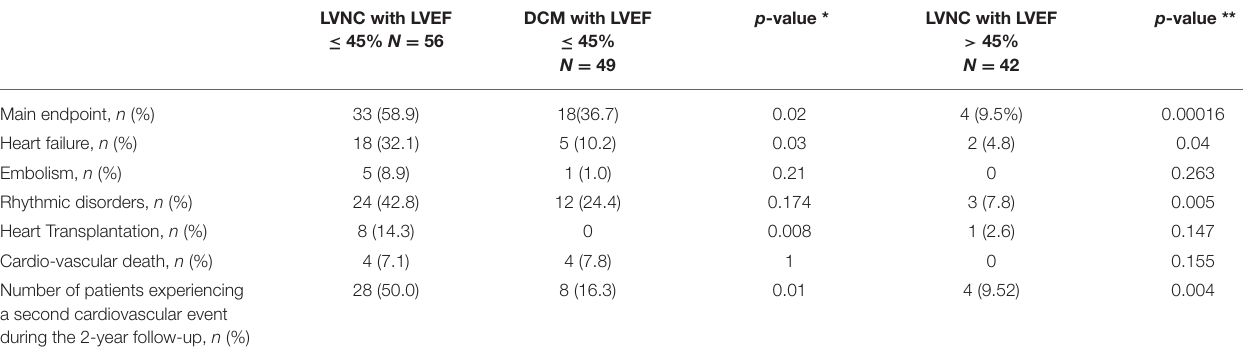
TABLE 3 | Five-year outcome.